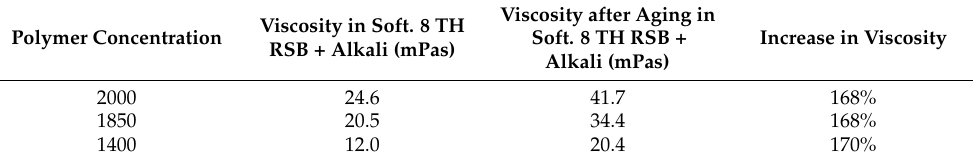
Table 6. Summary of concentrations and viscosities used here. Viscosity increases after aging, averaging